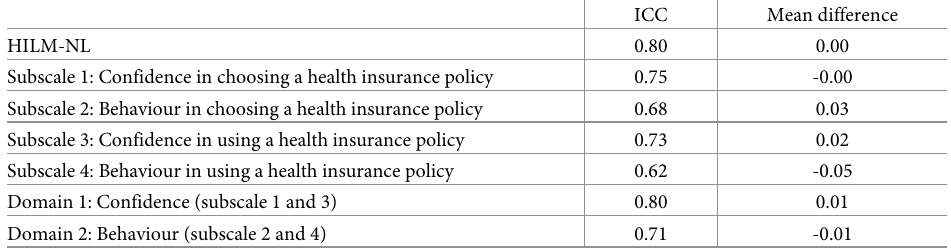
Table 4. Intraclass correlation coefficients and mean differences of the HILM-NL and its subscales and domains (n =